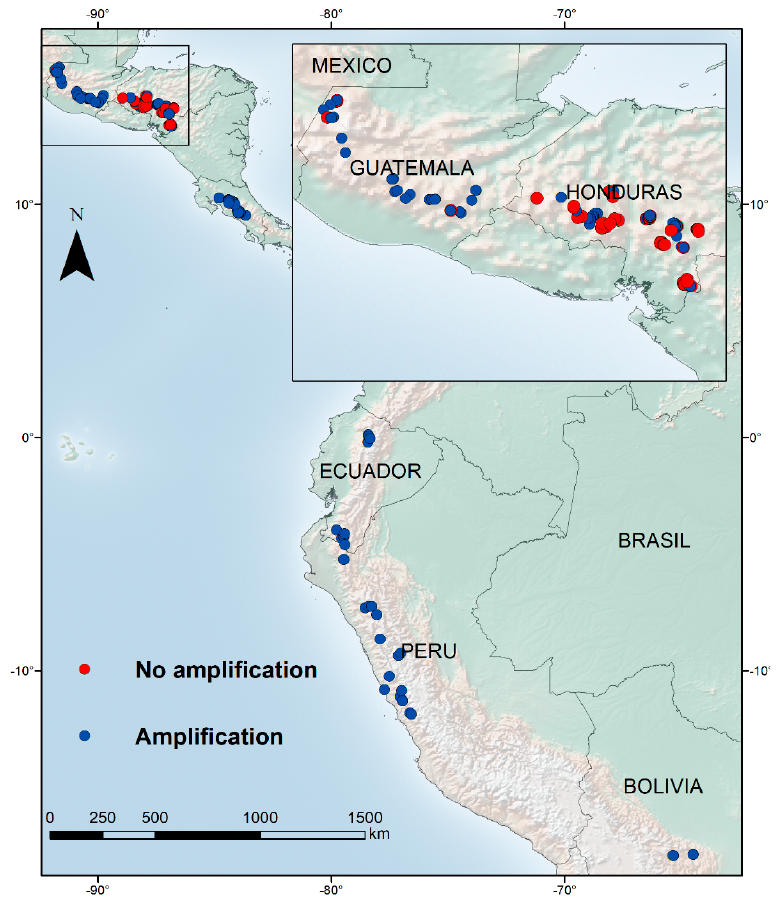
Figure 2. Geolocation of 411 A. cherimola samples amplified with AChF1 and AChR1. The blue color indicates the presence of an amplicon while the red color indicates the absence of amplification. Primers AChF2 and AChR2 amplified most of the accessions analyzed (546) except four (0.73%). Two of those belong to the germplasm field collection and their origin is the island of Madeira (Portugal) and the other two were collected in Guatemala. These last